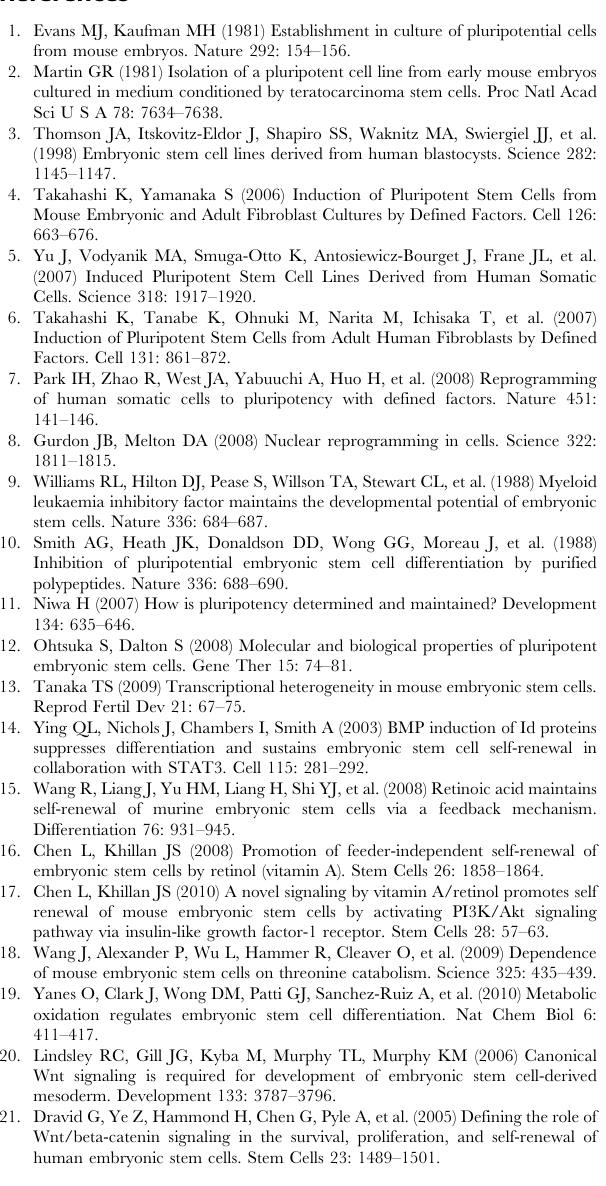
Figure S5 Expression levels of markers were compared among different culture conditions. Abundance of each transcript indicated above was examined in mESCs cultured under each condition on the right by 19, 21 and 23 cycles of PCR (indicated by triangles). Ef1 a was used as a reference. White arrowheads indicate the PCR product of c-Myc .